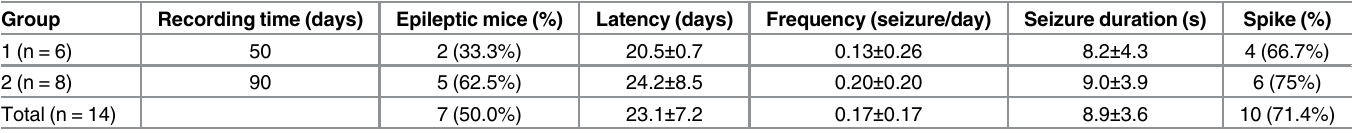
Table 1. Characterization of development of epileptiform activity after undercut Group